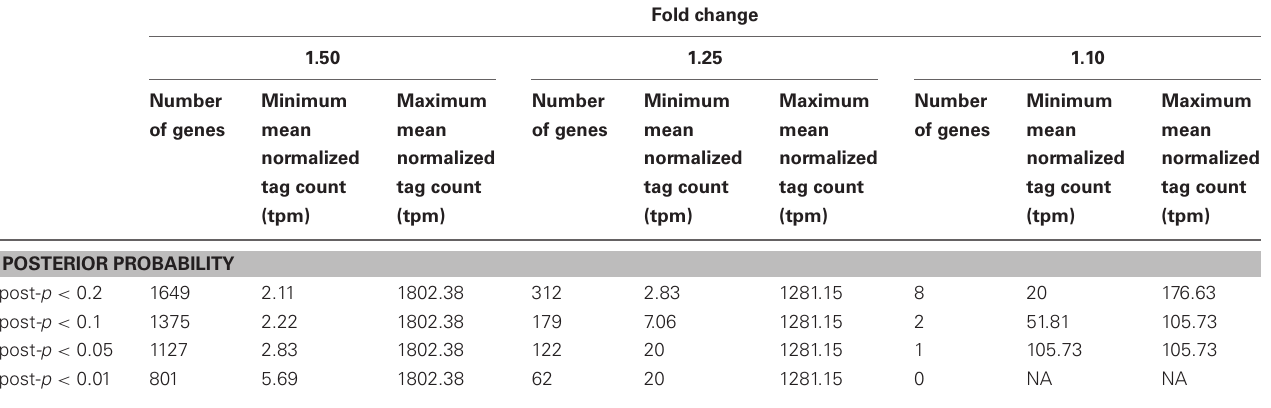
Table 1 | Gene counts for the fold change bins of 1.50, 1.25, and 1.10 across posterior probability cutoffs ranging from 0.01 to